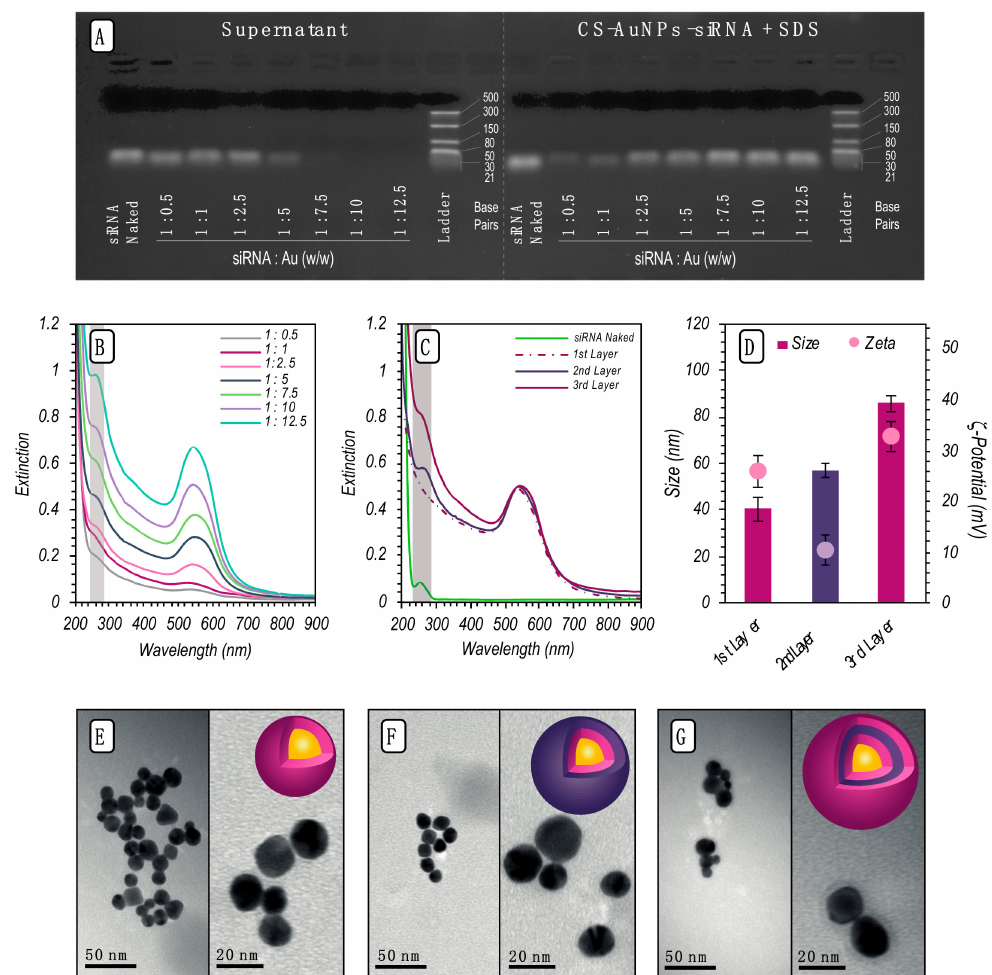
Figure 2. Synthesis of Layer by Layer (LBL) CS-AuNPs, ( A ) Agarose gel retardation assay of CS-AuNPs-siRNA complexes for various mass ratios of siRNA to Au ions (siRNA:Au) (1:0.5, 1:1, 1:2.5, 1:5, 1:7.5, 1:10 and 1:12.5). ( B ) UV-Vis spectra of CS-AuNPs-siRNA complexes for various mass ratios. ( C ) UV-Vis spectra upon sequential adsorption of siRNA and chitosan onto CS-AuNPs at weight ratio 1:10. ( D ) Representative particle size and zeta-potential after sequential adsorption of siRNA and chitosan on CS-AuNPs at weight ratio 1:10. ( E – G ) TEM images during the three steps of the LBL synthesis